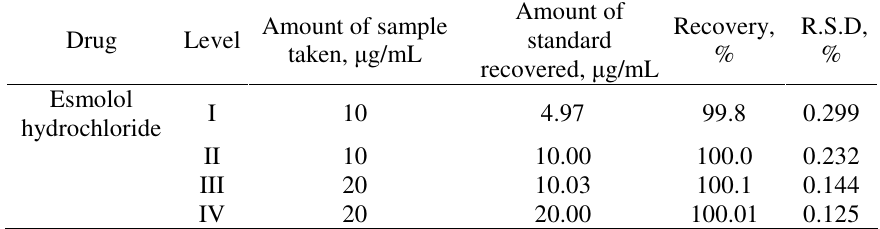
Table 3. Recovery data for the proposed RP-HPLC method (n=5).